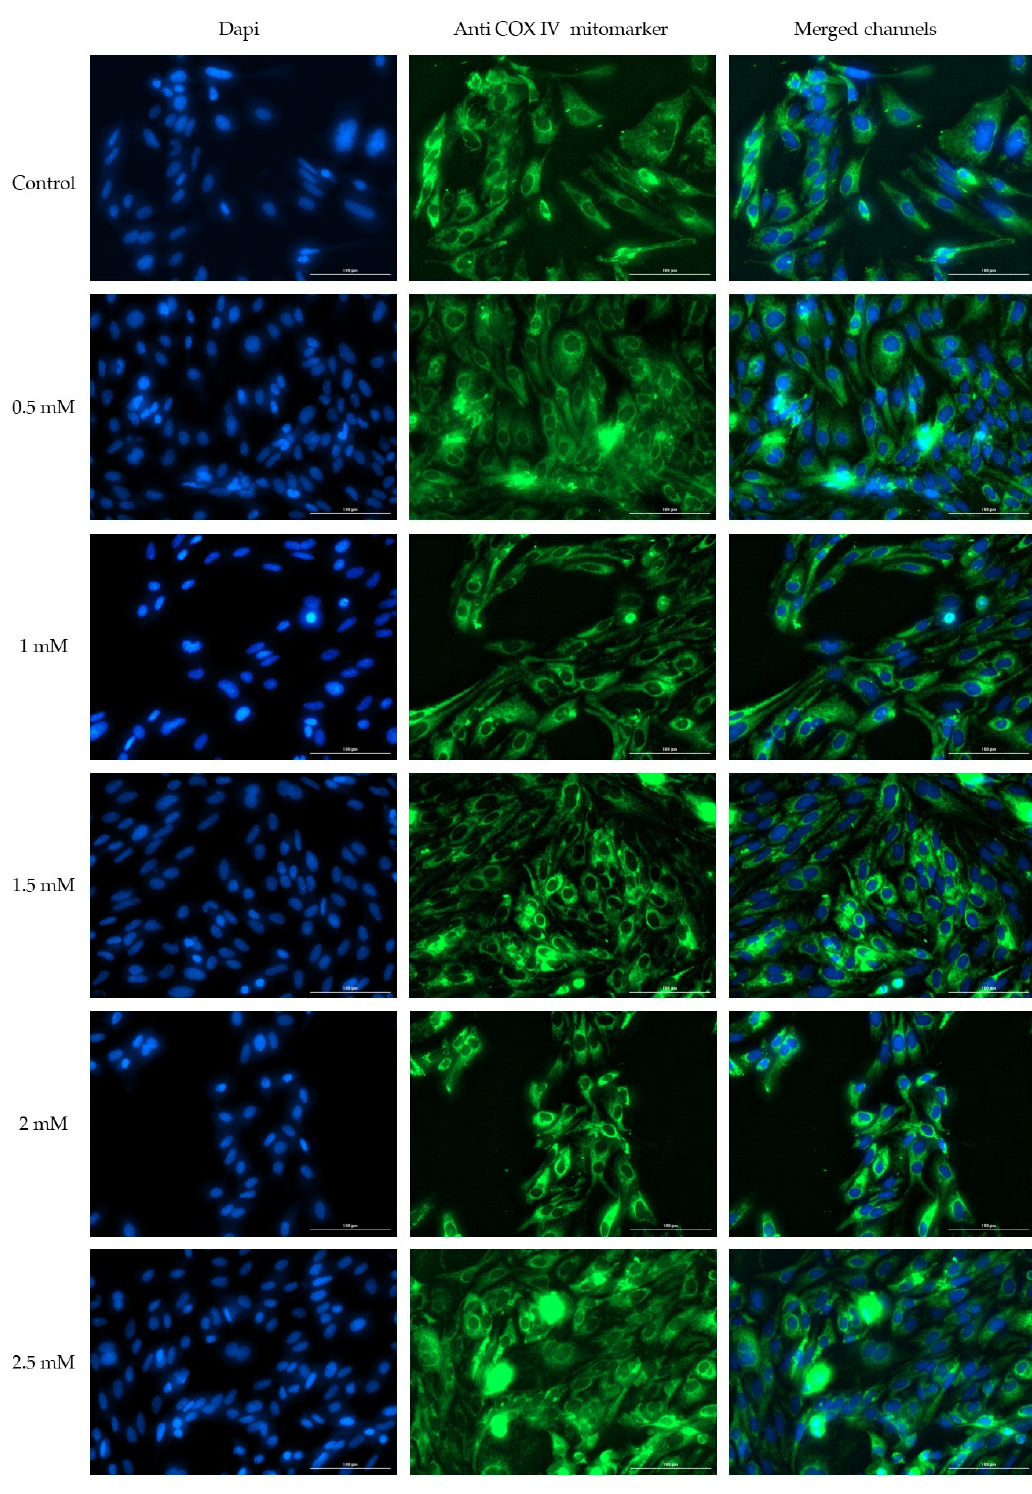
Figure 5. Effect of Met (0.5, 1, 1.5, 2 and 2.5 mM) after 72 h of stimulation on the HepaRG cells on nuclei—DAPI staining (blue) and COX IV mitochondrial marker (green).